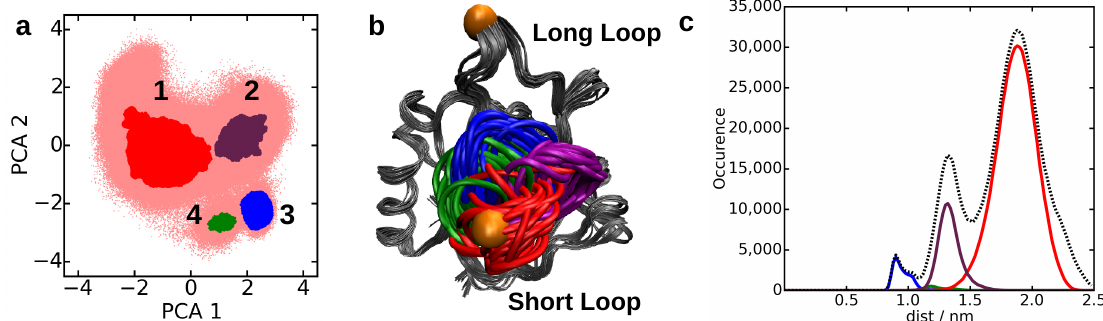
Figure 3. Molecular dynamics (MD) simulation trajectory of Langerin [33] ( a ) projected onto the first two principle components. Each core set (highlighted in different colors) represents a minimum of the potential energy surface spanned by the principle components and is linked to ( b ) a metastable state. (The core sets were identified by common nearest neighbor clustering, where the distance metric was the Euclidean distance in the space spanned by the first two principle components. A preprocessing of the MD dataset by principle component analysis is however not strictly necessary [4,24]). ( c ) Distance distribution of the distance Met260-Gly290 (highlighted in ( b ) by orange